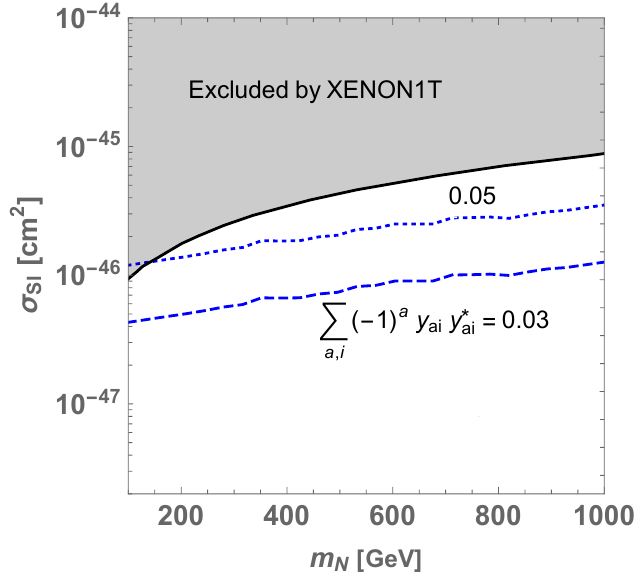
( − 1) a y = 0 . 03 ∗ ai y ai a,i